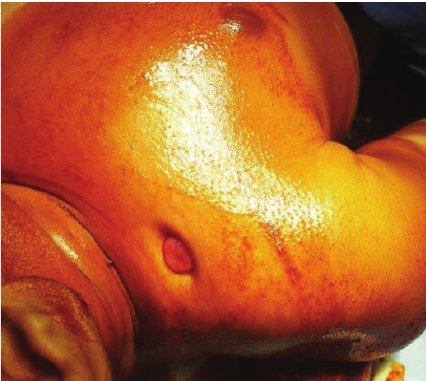
Figure 1: Clinical photograph of the right shoulder showing chronic discharging sinus over the clavicle.